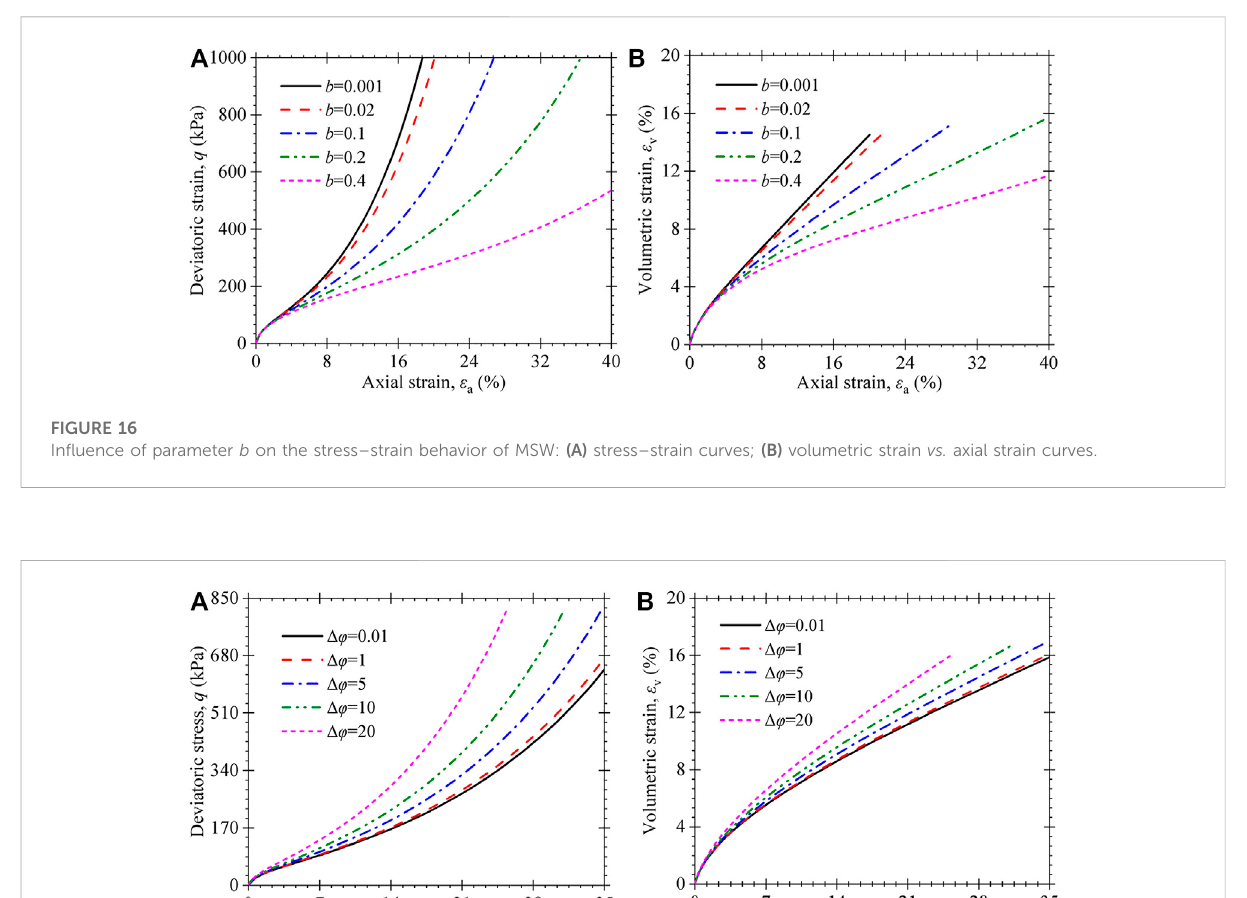
Frontiers in Earth